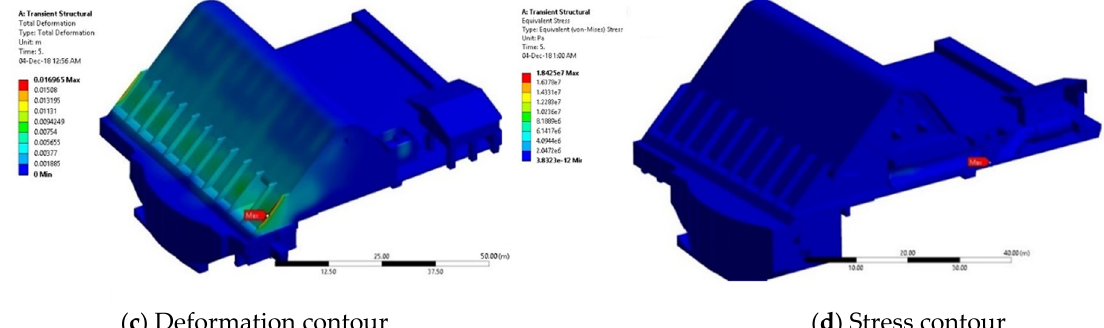
Figure 10. Contours on the bottom outlet with fully opened butterfly valve.